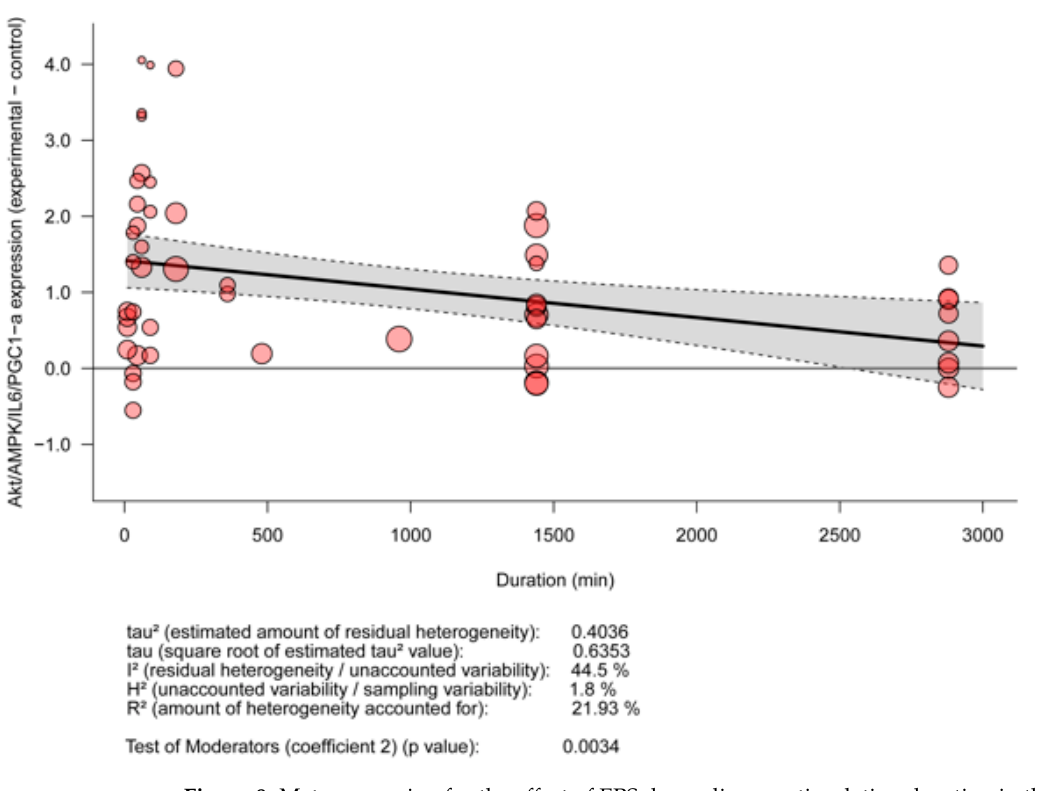
Figure 8. Meta-regression for the effect of EPS depending on stimulation duration in the expression of AMPK ( top ) and combined Akt, AMPK, IL-6, and PGC1a ( bottom ).